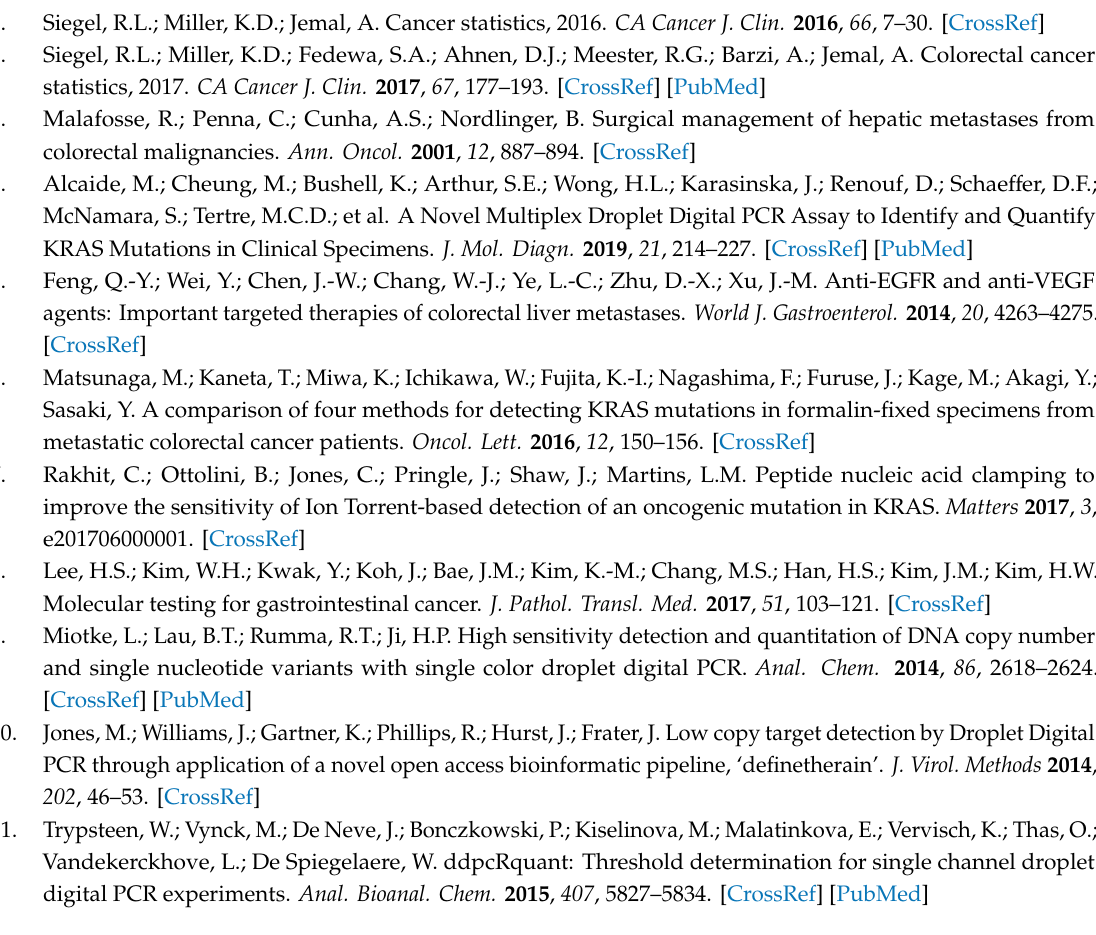
Table S1: Diagnostic value of KRA G12 / 13 mutation detection by ddPCR, Sanger sequencing, and PNA-clamping assay, and NGS panel sequencing (IonS5, Thermo Fisher